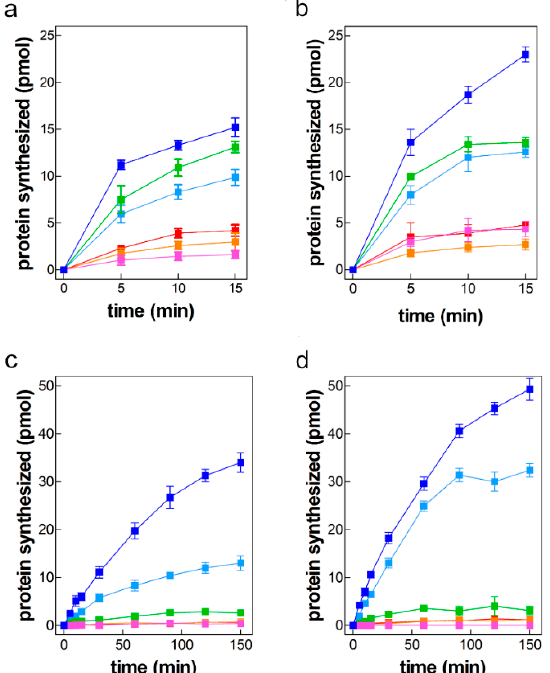
Figure 2. Translational activity of various mRNAs at 37 and 15 °C with cell extracts of control and cold-stressed cells. Time course of in vitro protein synthesis directed by mRNAs cspA (dark blue); cspD (red); A 1 A 2 D 3 (light blue); A 1 D 2 D 3 (green); D 1 A 2 A 3 (magenta); D 1 D 2 A 3 (orange) at 37 °C ( a , b ) and 15 °C ( c , d ) by cell extracts of control cells ( a , c ) and cells subjected to cold stress ( b , d ). Each data point is the mean of a duplicate and error bars indicate the standard deviation. The radioactivity incorporated in the absence of mRNA was taken as background and subtracted from each point. Further details are given in Materials and Methods.